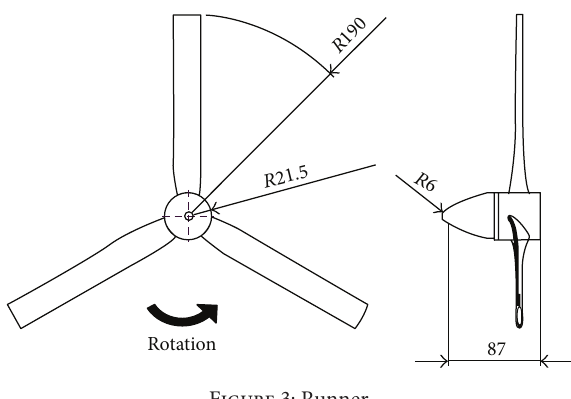
Figure 3: Runner.